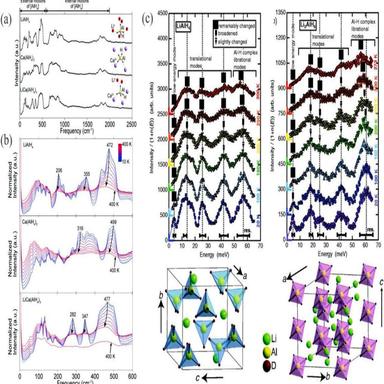
INS spectra of LiAlH4, Ca(AlH4)2 and LiCa(AlH4)3: (a) at 10 K, the inset figures display the corresponding local atomic structures around - for each alanate. The internal and external motions of - are at 600–2000 and 0–550 cm−1, respectively; (b) changes at 10–400 K; (c) INS spectra of LiAlH4 (left) and Li3AlH6 (right). The peak positions of the 20 K spectrum are indicated by the dotted vertical lines. The zero-intensity levels are vertically shifted by 500 and 150 units respectively in (lef